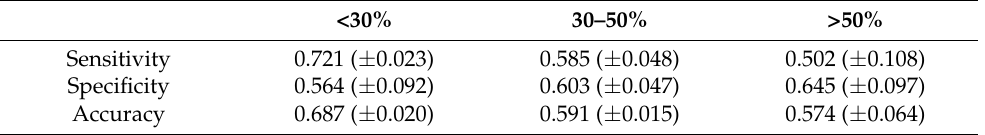
Table 11. Mean ± standard deviation of model performance parameters for the respective number of cross-validations among each sub-dataset with a low (<30%), medium (30–50%), and high (>50%) lameness incidence risk including animal and farm data, AMS data, and sensor